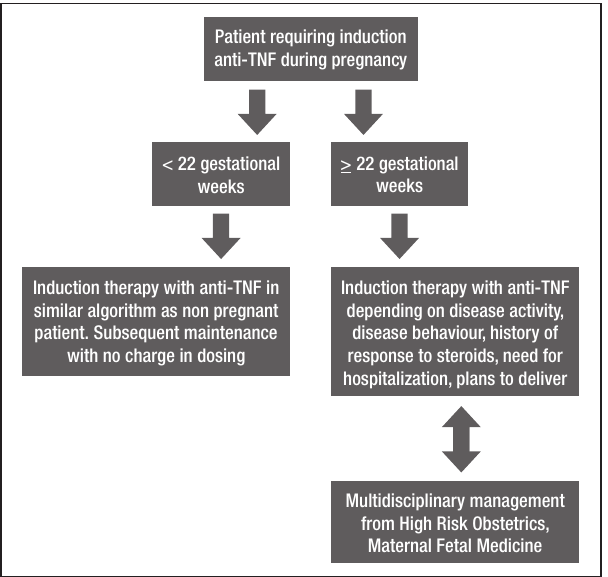
Figure 4) Algorithm for management of patients who need antitumour necrosis factor (anti-TNF) induction during pregnancy and subsequent